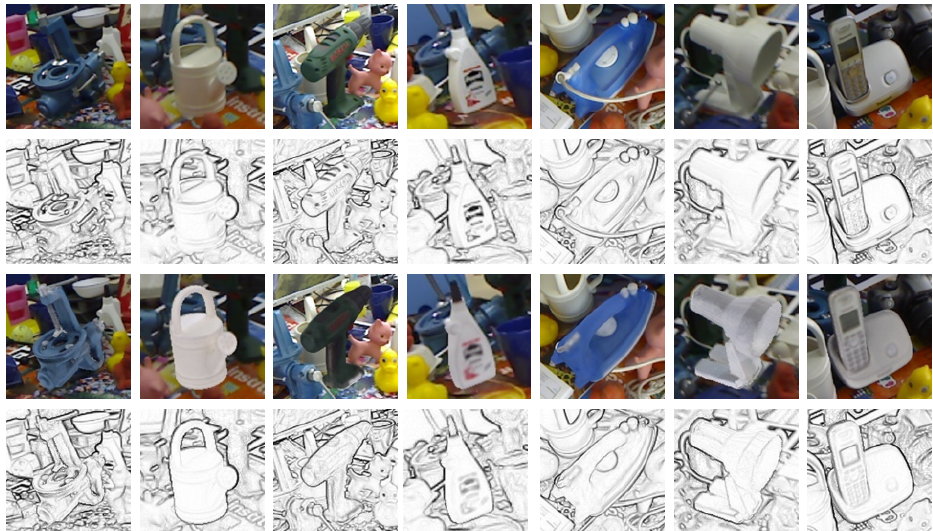
Figure 5. To visualize the effect of the pencil filter, we render the object model with the same pose over the real image. However, it should be noted that for training our network we only rendered the models on random backgrounds. First row: Cropped real images from the LINEMOD dataset [4]. Second row: Real images after applying pencil filter. Third row: Rendered images with same object pose and background as the first row. Fourth row: Rendered images after applying pencil